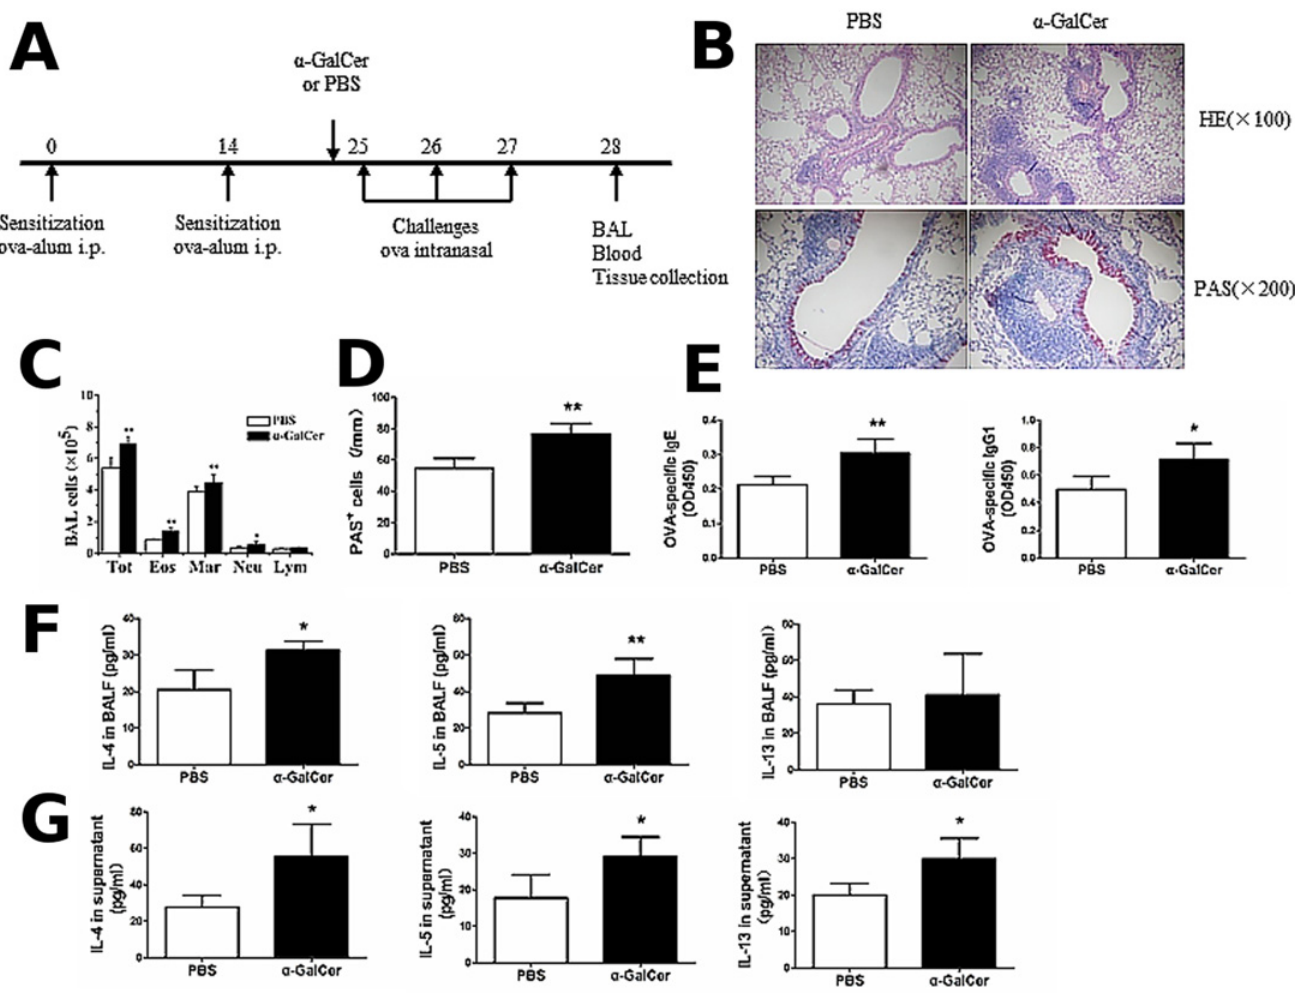
Fig 5. α -GalCer administration enhances the Th2 inflammatory response in OVA-induced asthma model. A . Timeline of the OVA immunization/ challenge protocol and the names of the treatment groups ( α -GalCer or PBS). B . Histopathological analysis using hematoxylin-eosin (H&E) staining and periodic acid-Schiff (PAS) staining of the lung tissue sections from OVA-induced asthmatic mice treated with α -GalCer or PBS. C . Total cell and differential cell counts in the BALF from OVA-induced asthmatic mice treated with α -GalCer or PBS were obtained by a standard hemocytometer. N = 4 per group and * P < 0.05, ** P < 0.01. Tot, total cell counts; Mar, macrophages; Eos, eosinophils; Neu, neutrophils; and Lym, lymphocytes. D . Lung goblet cell hyperplasia is expressed as the number of PAS-positive cells per unit of length (mm) of the basement membrane. N = 4 per group and ** P < 0.01. E . OVA-specific Ig levels from OVA-induced asthmatic mice treated with α -GalCer or PBS were analyzed by ELISA. N = 4 – 5 per group and * P < 0.05, ** P < 0.01. F . BALF were collected and cytokine (IL-4, IL-5, and IL-13) production from OVA-induced asthmatic mice treated with α -GalCer or PBS was analyzed by ELISA. N = 4 per group and * P < 0.05, ** P < 0.01. G . Splenocytes were obtained and re-stimulated with 500 μ g OVA in vitro from OVA-induced asthmatic mice treated with α -GalCer or PBS. After 72 h, culture supernatants were collected and cytokine production was analyzed by ELISA. N = 4 per group and * P <